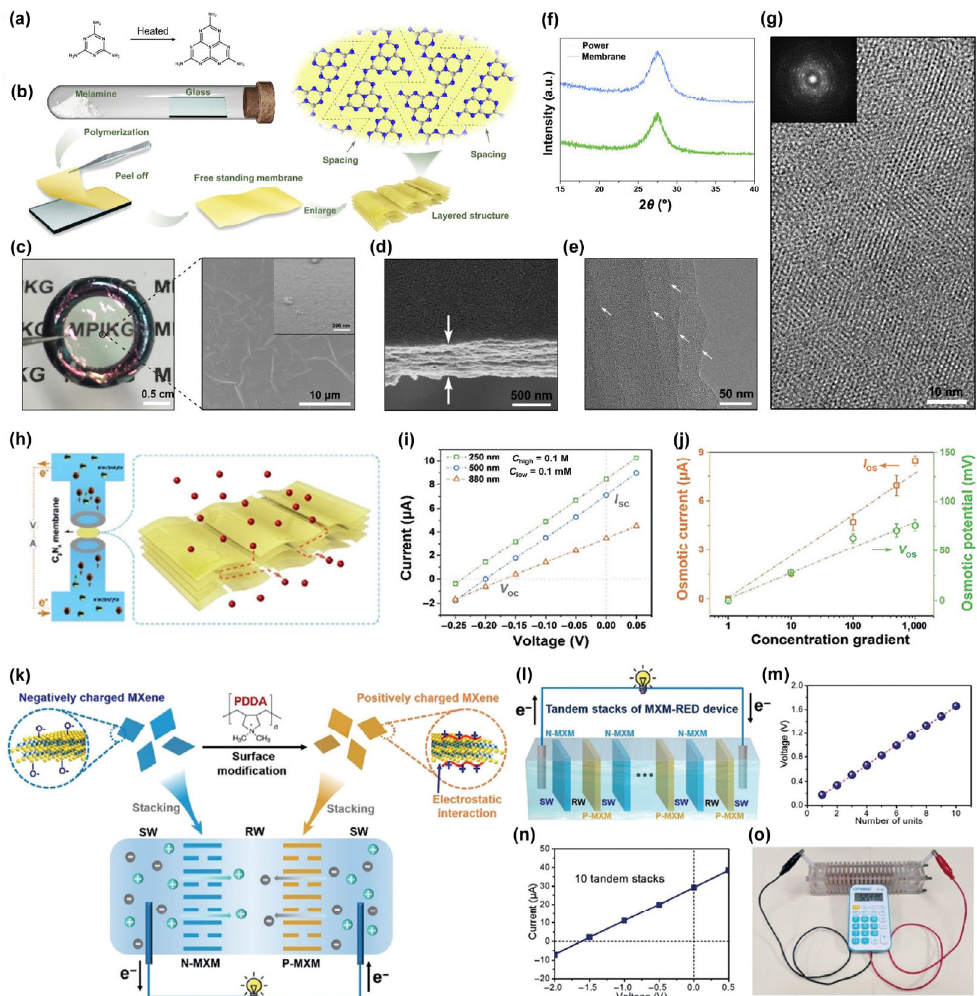
Figure 4 The synthesis procedure of carbon nitride membrane (a). Vapor-deposition polymerization and the molecular structure of carbon nitride (b). Optical and SEM image of the free-standing membrane (c). Cross-section image (d). TEM of the layered structure (e). X-ray diffraction (XRD) of the carbon nitride powder and membrane (f). High-resolution TEM (HRTEM) and electron diffraction images which indicate the crystallinity of the carbon nitride membrane (g). Schematic of the ion transport across the membrane (h). I–V curves of the membrane with different thicknesses under 0.1 M/0.1 mM NaCl (i). The osmotic current and osmotic potential for carbon nitride membrane with the thickness of 250 nm as a function of concentration gradients (j). Reproduced with permission from Ref. [56], © Wiley-VCH Verlag GmbH & Co. KGaA, Weinheim 2018. Scheme of the full reverse electrodialysis cell using MXene membrane pairs. The surface charge of MXene can be tuned from negative to positive, acting as cation- and anion-exchange membranes, respectively (k). Schematic of the tandem of membrane-pair stacks (l). The output voltage of 10 MXene RED cells stacked in series (m). I–V curves of 10 tandem membrane-pair stacks (n). The tandem cells can power a calculator with a working voltage of 1.5 V (o). Reproduced with permission from Ref.